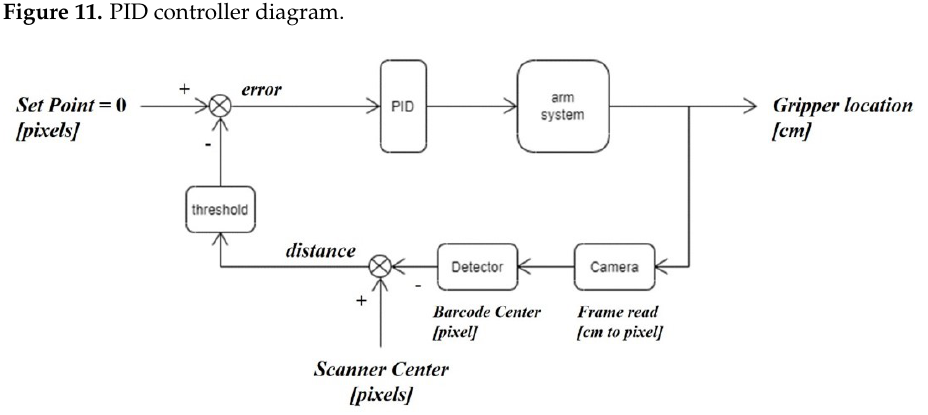
Figure 12. The closed-loop PID system.